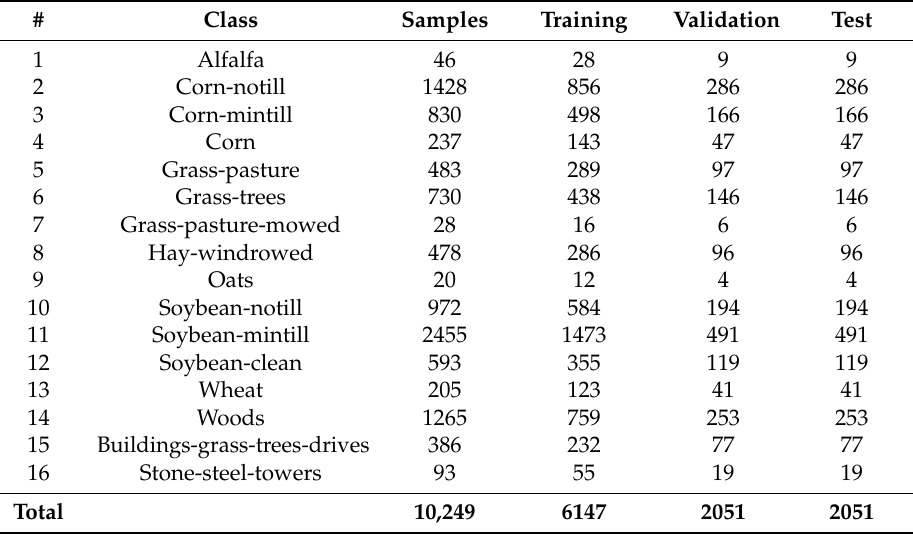
Table 2. Land cover classes and numbers in Indian Pines.